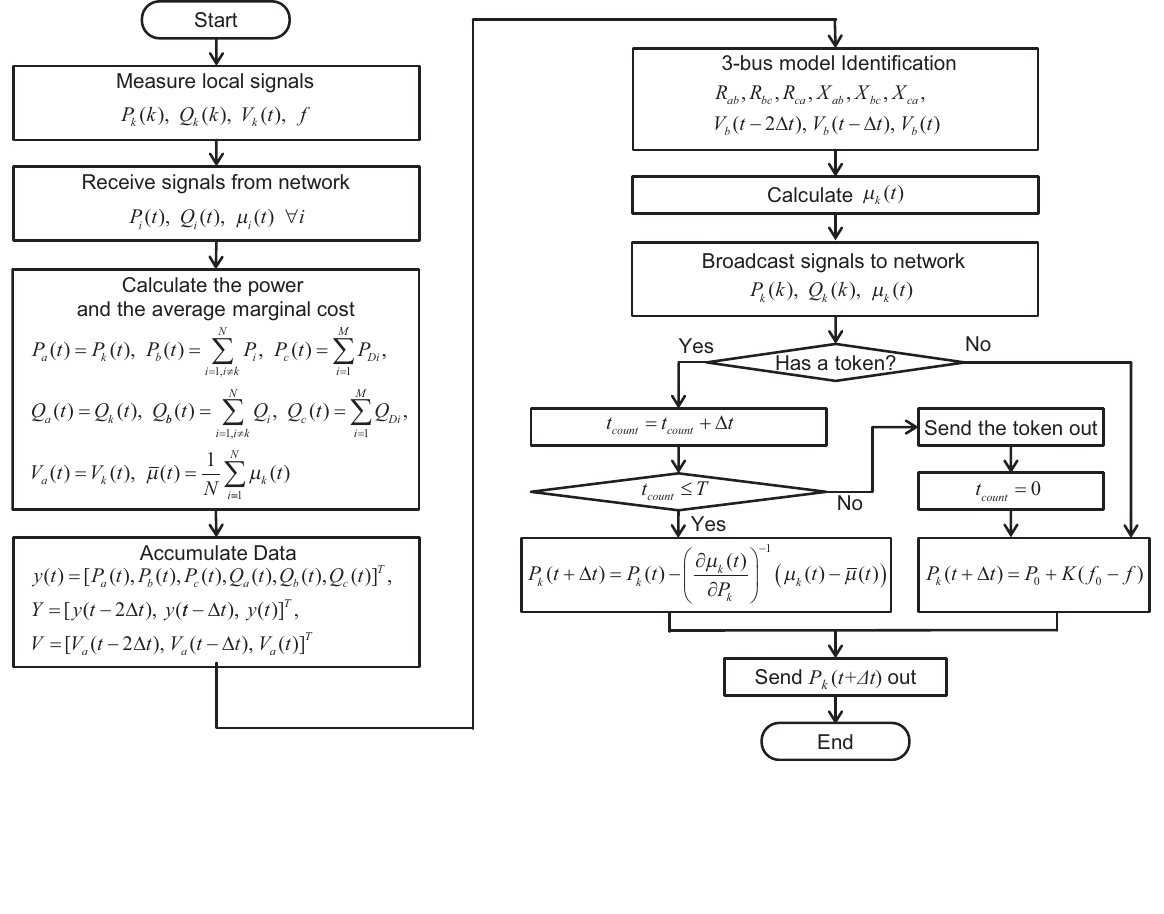
Figure 2. Flow chart of the control algorithm. The variables are defined as follows: t the time counter; Δ t is the time step; and, T is the control time